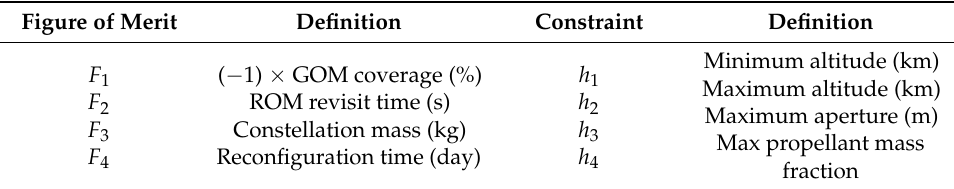
Table 1. Figures of merit and constraints in ReCon optimization. Figure of Merit Definition